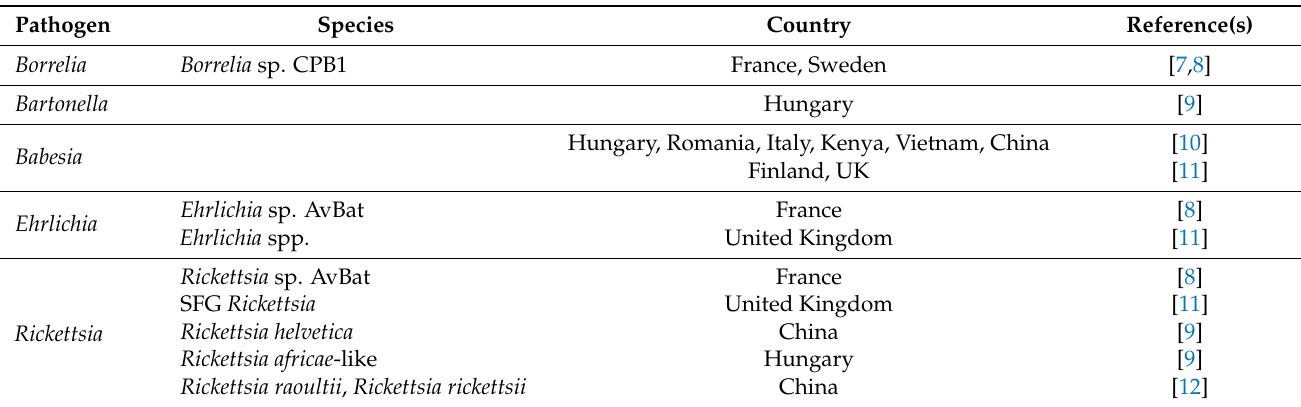
Table 1. Bacteria identified in C. vespertilionis ticks collected from different